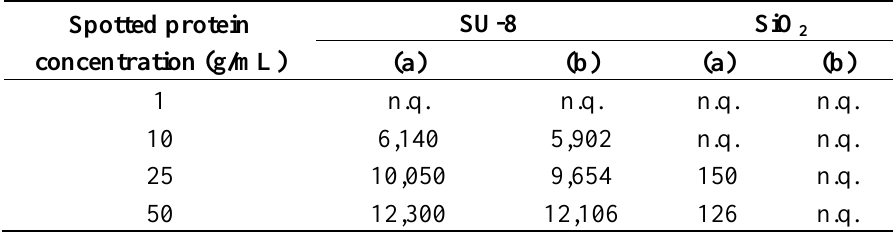
Table S1. Average neat fluorescence intensity (a.u.) obtained for Cy5 labelled protein microarrays immobilized on SU-8 coated and SiO acidic washing